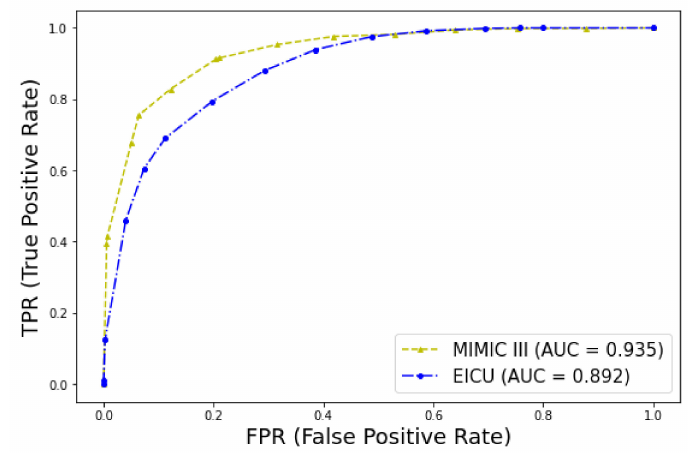
Figure 8. ROC curves for early mortality in ICU patients with thrombosis. Validation of the model in the two datasets.